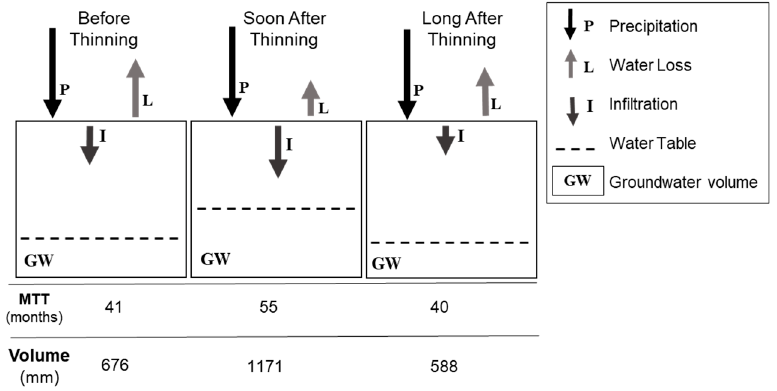
Figure 5. Schematic diagram illustrating hydrological processes in the study area during the “before thinning” (2010–2011), “soon after thinning” (2011–2013), and “long after thinning” (2017–2021) study periods. Arrow lengths demonstrate changes in the amount of water loss and infiltration, with the precipitation arrow remaining stable. The water table line indicates fluctuations in groundwater storage. The MTT and volume are shown below the diagram.